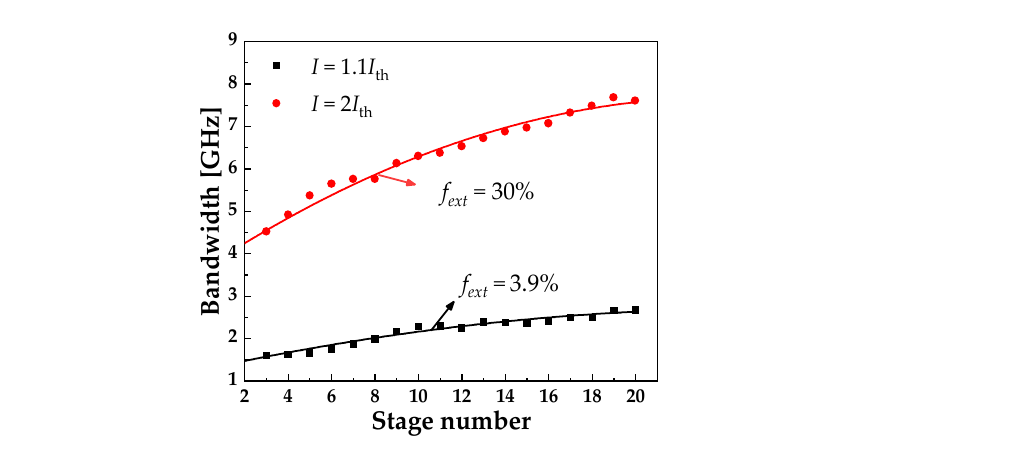
Figure 12. Bandwidth of chaos vs. stage number I = 1.1 I th (black squares) and I = 2 I th (red circles) with τ f = 2.4 ns.